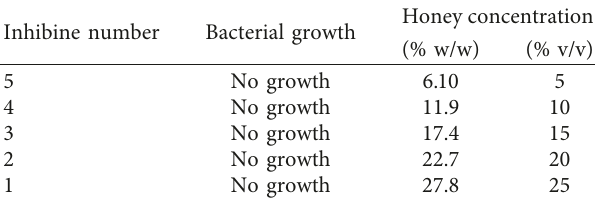
Table 1: Honey inhibine number and its relationship with honey concentration. Inhibine number Bacterial